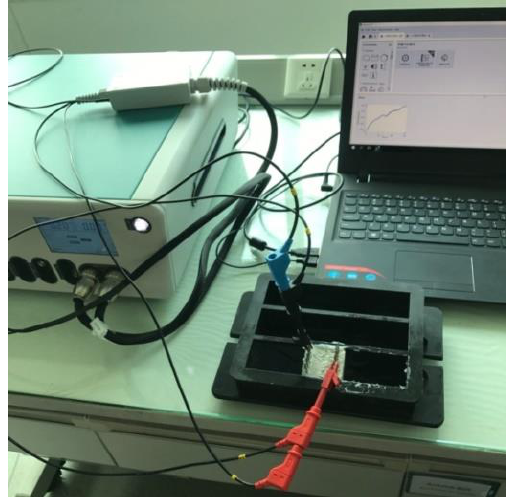
Figure 3. Open circuit potential test.